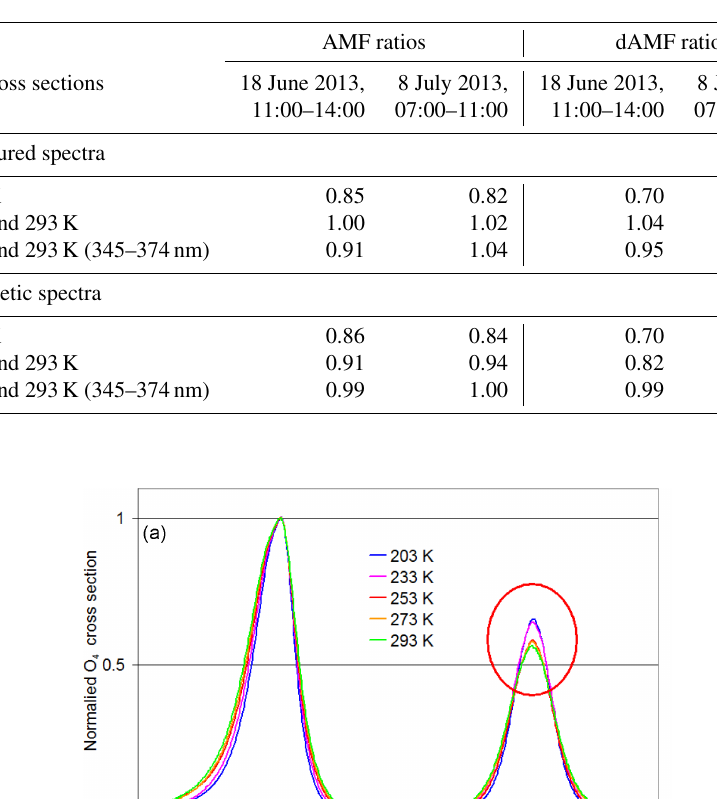
Table A24. Average ratios of O 4 (d)AMFs derived from O 4 cross sections at different temperatures (either 203K or both 203 and 293K) vs. those for the standard analysis (using the O 4 cross section for 293K) for the middle period on each selected day (top: results for spectra measured by the MPIC instrument; bottom: results for synthetic spectra when taking into account the temperature dependence of the O 4 cross section). For the simultaneous fit of both temperatures the results for the spectral range 345–374nm (one O 4 absorption band) are also included.